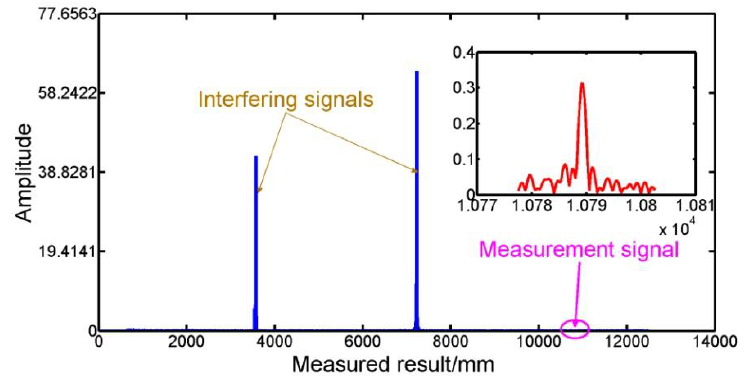
Figure 4. Measured result without cooperative target.